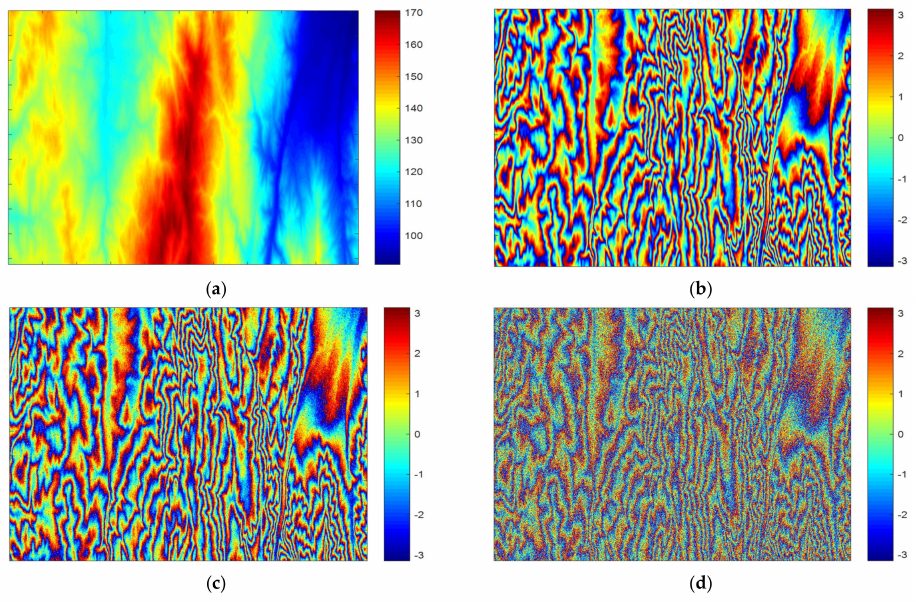
Figure 4. ( a ) The DEM used to generate the training sets; ( b ) clean interferogram generated by ( a ); ( c ) noisy interferogram with a coherence coefficient of 0.95; ( d ) noisy interferogram with a coherence coefficient of 0.5.